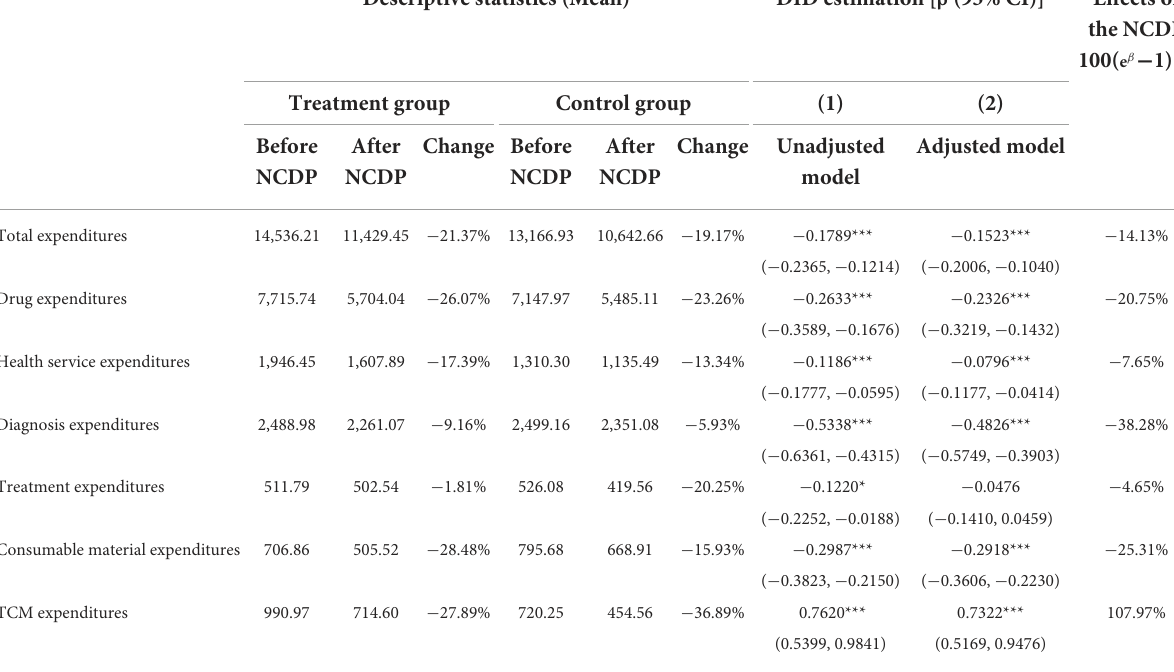
TABLE 3 Expenditures of cancer patients and effects of the NCDP policy on medical expenditures